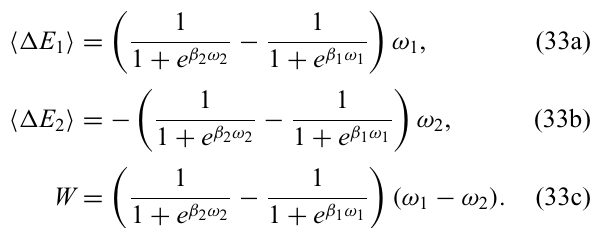
FIG. 10. (a),(c),(e) Measured rescaled energy exchanges (cid:2) /ω (cid:5) (cid:10) E (cid:2) /ω (cid:5) W (cid:2) /ω , for the SWAP engine in Fig. 7 as (cid:5) (cid:10) E 1 1 , 2 2 , a function of nominal inverse rescaled temperatures β 1 ω 1 , β 2 ω 2 . (b),(d),(f) Their relative experimental